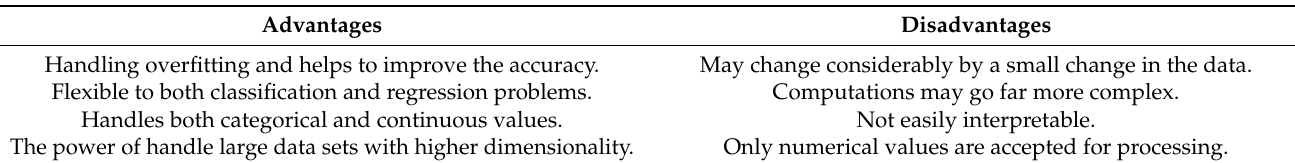
Table 7. Advantages and disadvantages of RF.